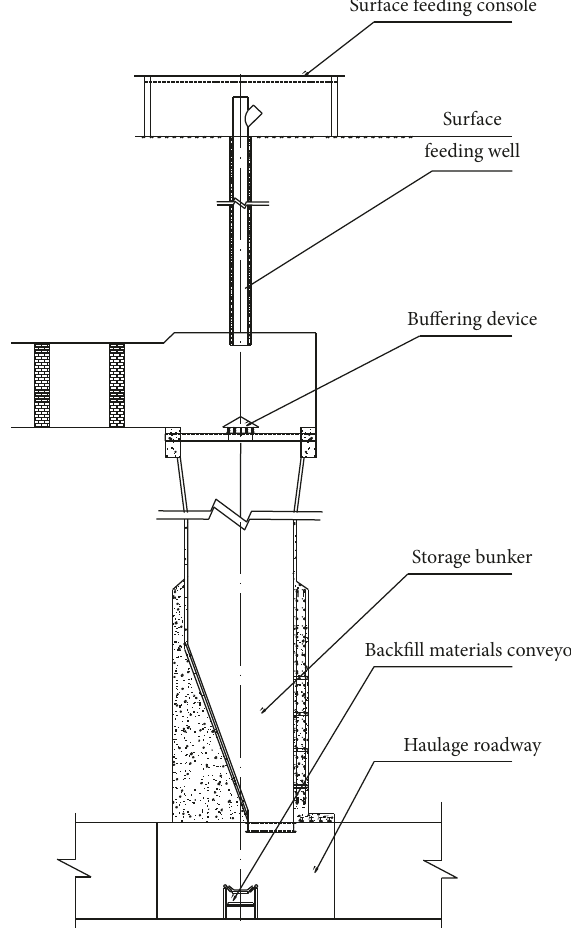
Figure 1: Solid filling material vertical feeding